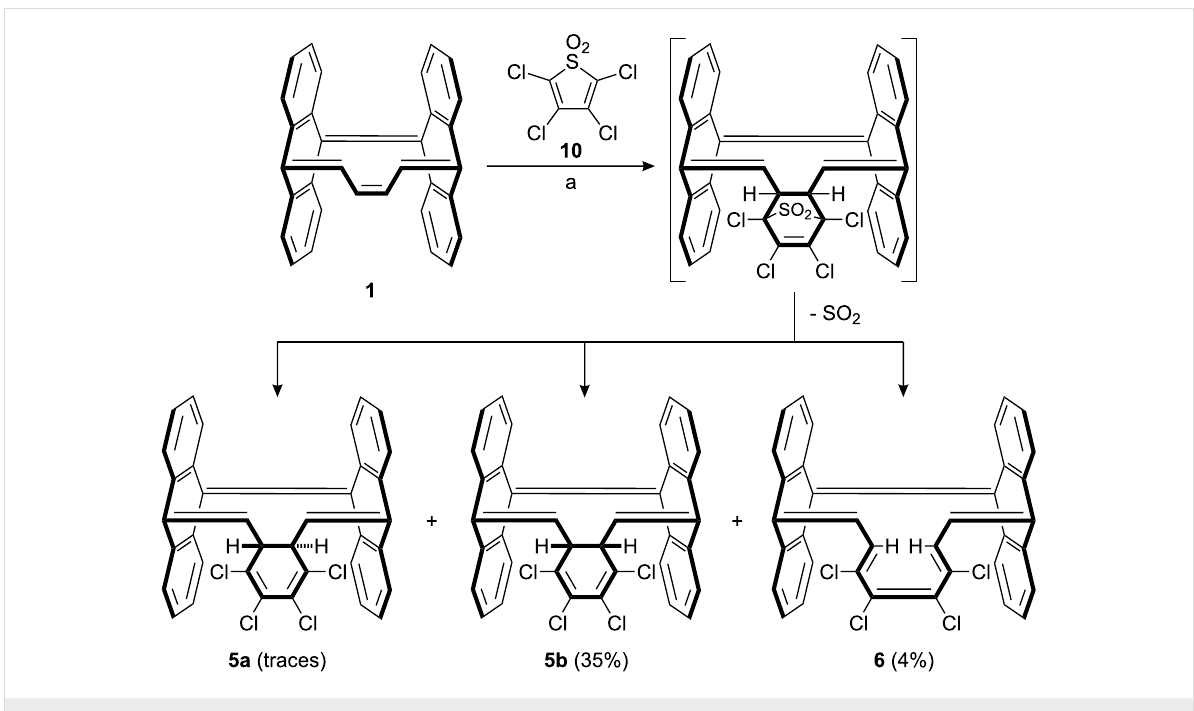
Scheme 3: Synthesis of 5 and 6 . (a) Toluene, 90 °C, 15 h.